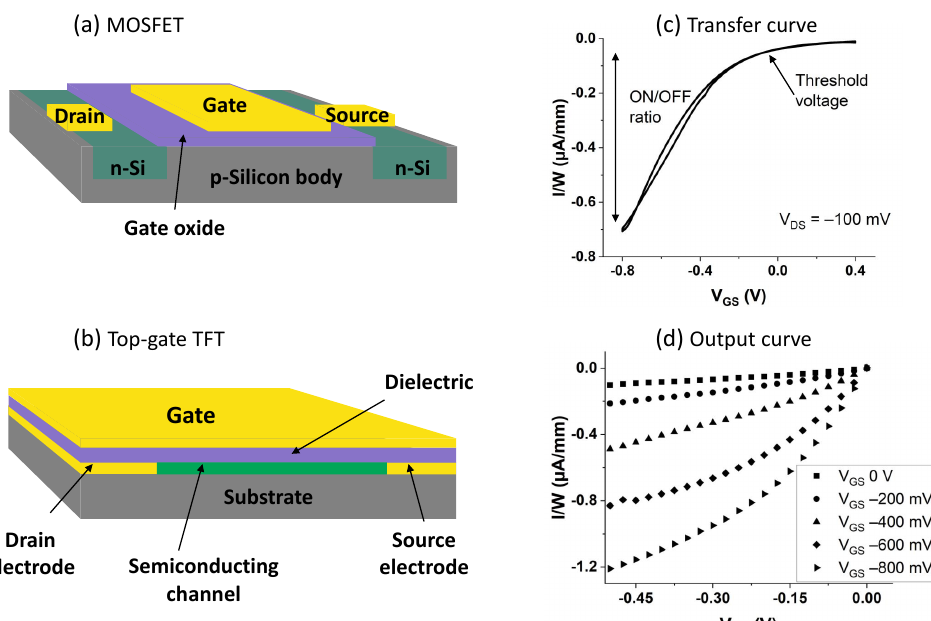
Figure 1. ( a ) MOSFET with the main p-Si body and two n-Si regions. ( b ) Top-gate TFT on a substrate that could be many type of materials (both rigid or flexible) and the other layers deposited on top of it. ( c ) Transfer curve of a FET presenting a p-type behavior; I/W is the measured current divided by the channel width. ON/OFF ratio is I ON /I OFF ; threshold voltage (V TH ) is the V GS at which FET turns on. ( d ) Output curves of a p-type FET-device; curves were obtained at different fixed V GS